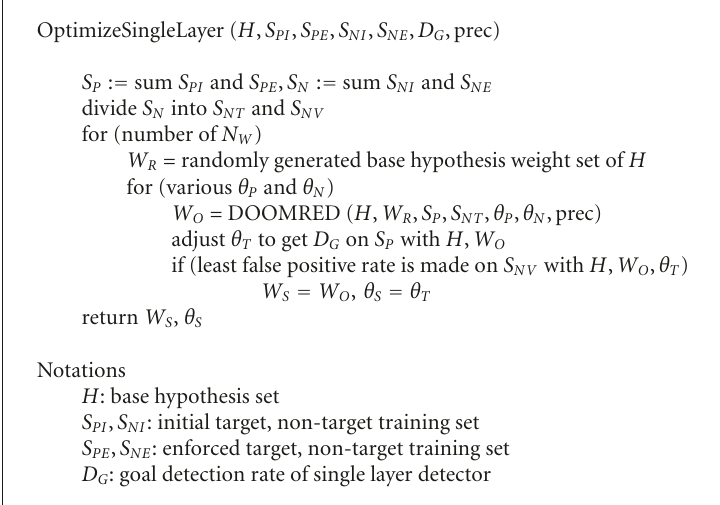
Algorithm 2: The pseudocode for the optimization of the boosted single layer detector on the enforced training set.